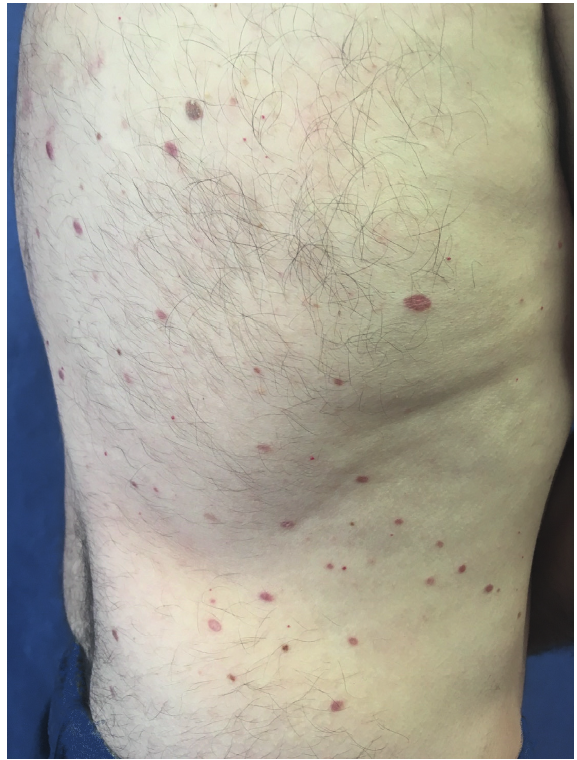
Figure 1: Multiple yellow-brown papules in the trunk.